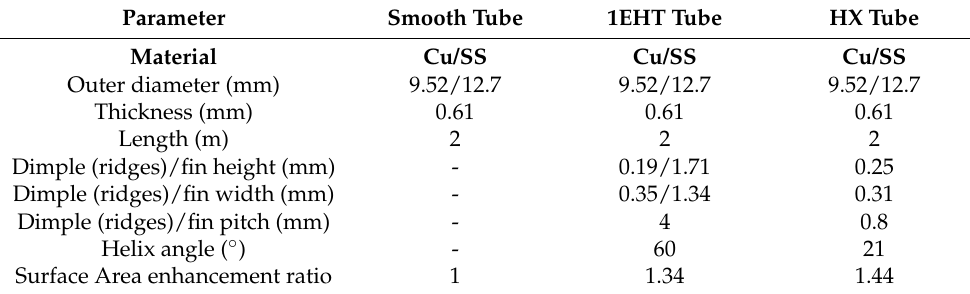
Table 1. Geometric